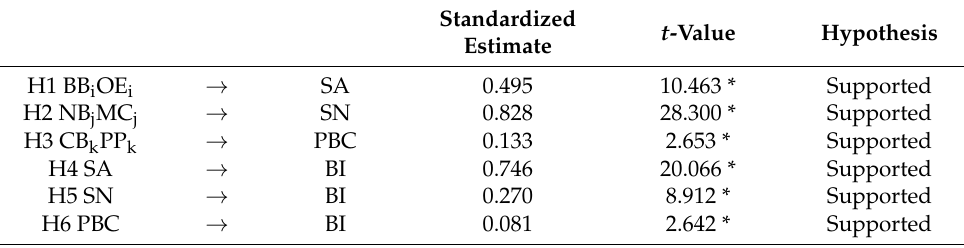
Table 3. Standardized parameter estimates for structural